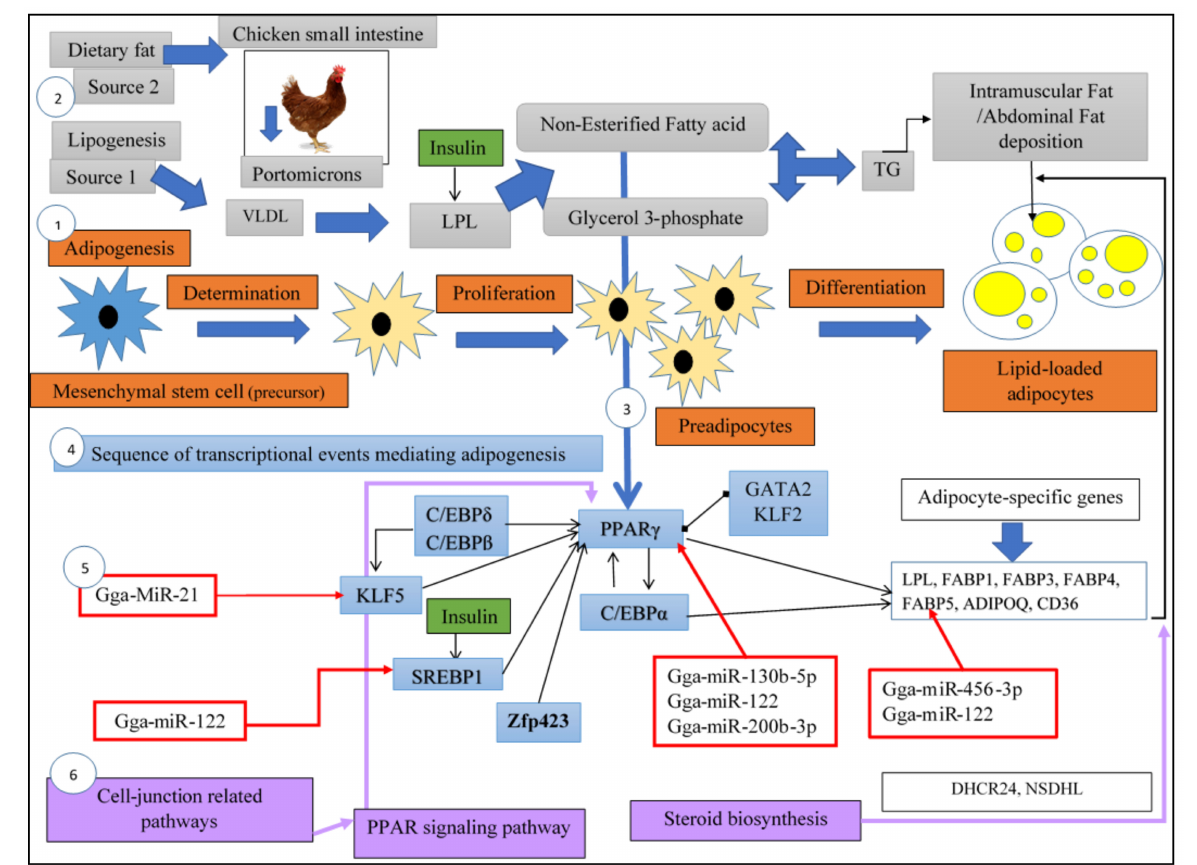
Figure 2. Schematic representation of adipogenesis and fat deposition and their regulation at the transcriptional and post- transcriptional level in the chicken adipocyte. Several regulatory factors, including hormones (green boxes), transcriptional factors (blue boxes), miRNAs (red boxes), and their target genes, controlling adipogenesis and fat deposition in chicken. 1—Adipogenesis (orange boxes) is the process of differentiation in which mesenchymal cells turn into mature adipocytes. 2—The fatty acids released from VLDL can penetrate adipocytes, which inside adipocytes resynthesized into TG and deposited. Accumulated fat in chicken adipose tissue consists of TG either from plasma VLDL (source 1) or from dietary fats (portomicrons) (source 2). 3—The presence of exogenous fatty acids (from VLDL or diet) is vital for regulating the expression of peroxisome proliferator-activated receptor- γ (PPAR γ ). 4—The blue boxes revealed the sequence of transcriptional factors controlling adipogenesis; the early transcriptional regulators, including CCAAT/Enhancer binding-protein (C/EBP β and C/EBP δ ) express and stimulate the key transcription factors, including PPAR γ and C/EBP α which at terminal differentiation stage, regulate the transcriptional regulation of a variety of adipocyte-associated genes, such as lipoprotein lipase (LPL), fatty-acid-binding proteins (FABP), cluster of differentiation 36 (CD36), and adiponectin, C1Q and collagen domain-containing (ADIPOQ). PPAR γ and C/EBP α are the master regulators of adipogenesis that can crossregulate each other. Sterol response element-binding protein (SREBP1) is regulated by insulin and can regulate adipogenesis by inspiration the expression of PPAR γ through adipogenesis. Kruppel-like transcription factor (KLF5) is activated by C/EBP β / δ through the early stages of adipogenesis and then promotes the expression of PPAR γ . KLF2 and GATA binding protein 2 (GATA2) are the anti-adipogenic transcription factors, which lead to adipogenesis repression through inhibition of the expression of PPAR γ . Zinc finger protein 423 (Zfp423) regulates preadipocyte cell determination through regulation of PPAR γ expression. 5—The red boxes indicated various significantly expressed miRNAs with regulatory effects on adipogenesis. 6—Fat deposition in chicken is mediated and regulated by different signaling pathways (purple boxes), including the PPAR signaling pathway and the cell junction pathways (focal adhesions, tight junction, ECM-receptor interaction, regulation of actin cytoskeleton). The cell junction-related pathways may mediate the PPAR signaling pathway after activating PPAR γ . Then PPAR γ upregulates the expression of lipogenic-related genes, such as FABP3, LPL. The steroid biosynthesis pathway through regulating the expression of genes, such as 24-dehydrocholesterol reductase (DHCR24) and NAD(P) dependent steroid dehydrogenase-like (NSDHL), might play a dominant role in fat deposition in chicken (). Open arrows and diamond arrows represented the stimulating and inhibition effects,